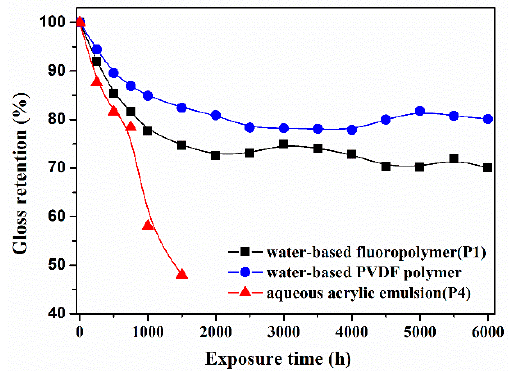
Figure 9. Quick ultraviolet (QUV) tests of different types of waterborne polymer. PVDF: polyvinyldene fluoride.